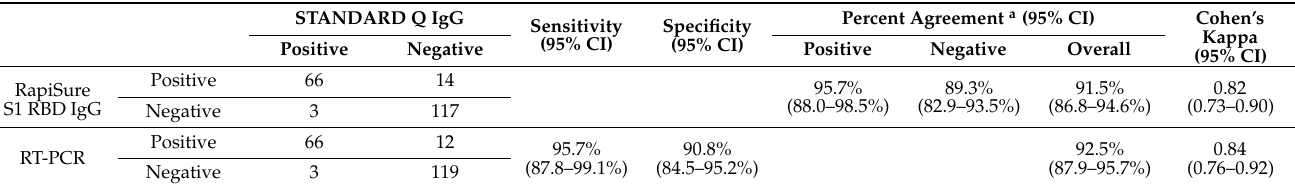
Table 2. Comparison between the RapiSure COVID-19 S1 RBD IgG test results and the IgG test results obtained using STANDARD Q COVID-19 IgM/IgG Plus. The results of the STANDARD Q IgG test were also compared to those of COVID-19 RT-PCR.